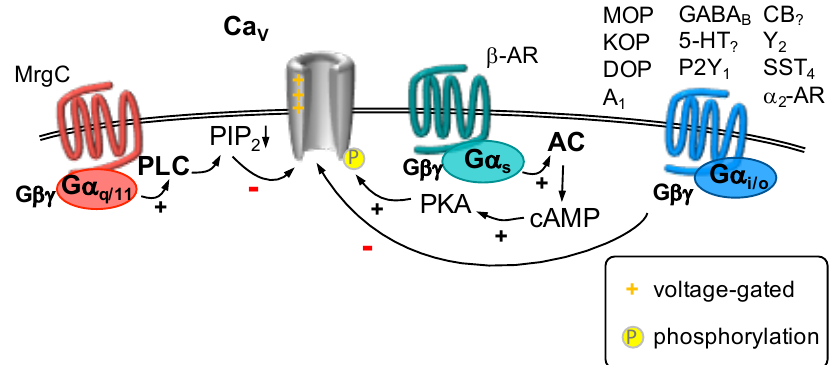
Figure 6. Ca V channels are activated by depolarizing voltages (as indicated). Activation of a G α i / o -coupled receptor ( right ) leads to a phenomenon called “voltage-dependent inhibition”. This involves direct binding of the G βγ dimer to Ca V 2.x channels. Activation of G α s -coupled receptors ( center ) leads to activation of adenylyl cyclase (AC), which forms cAMP (cyclic adenosine monophosphate) to activate protein kinase A (PKA). PKA-mediated phosphorylation of Ca V 1.x channels was shown to increase their currents. Activation of a G α q /11 -coupled receptor ( left ) stimulates phospholipase C (PLC), which hydrolyzes phosphatitylinositol 4,5 bisphosphate (PIP 2 ). Depletion of PIP 2 is sufficient to decrease currents through Ca V